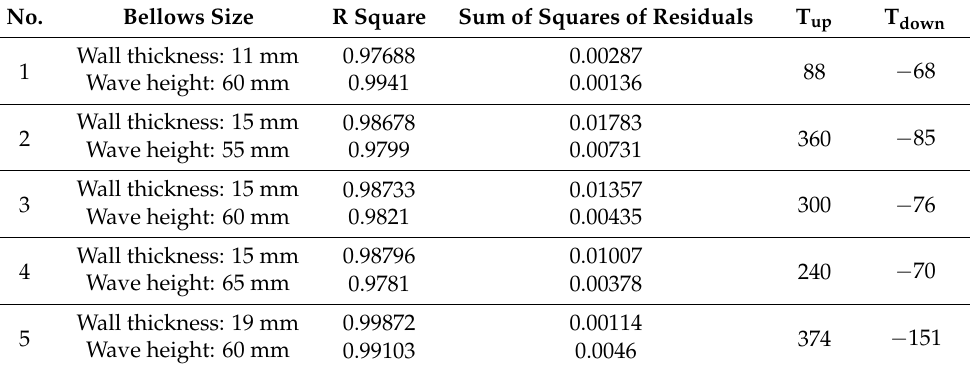
Figure 12. Difference between displacement and temperature curves of different arrangements. Table 3. Statistics of the fitting equation of the compensation difference of bellows of different sizes in different